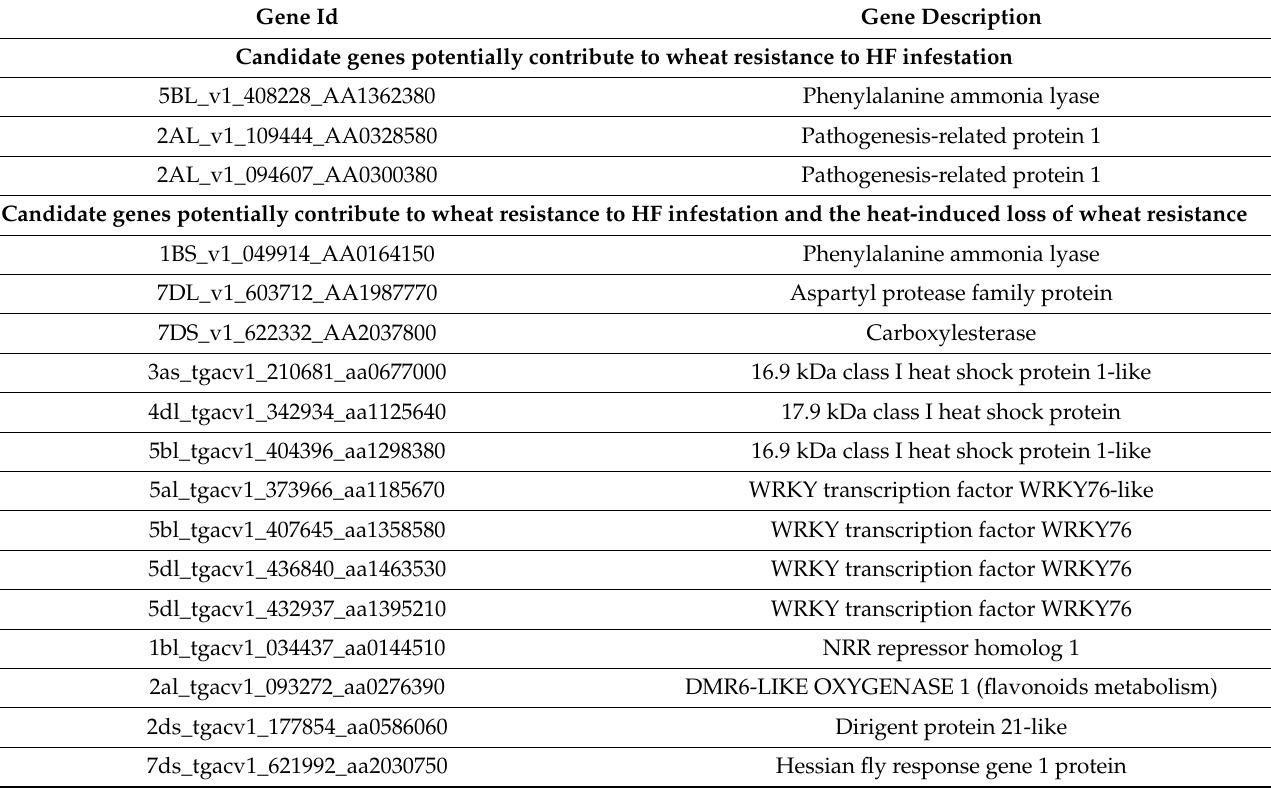
Table 4. Selected candidate genes potentially contributing to wheat resistance to HF infestation and/or the heat-induced loss of wheat